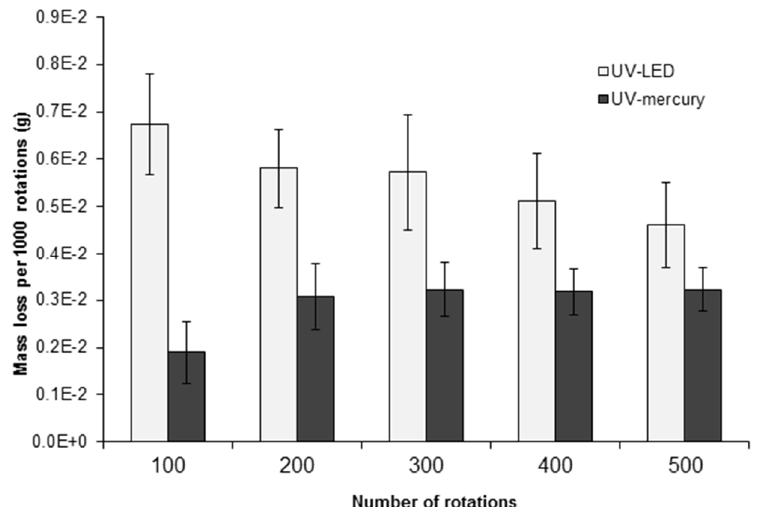
Figure 5. Graph of the mass loss per 1000 rotations in function of block of 100 rotations and reported on a comparative basis of a 1000 cycle (wear index).